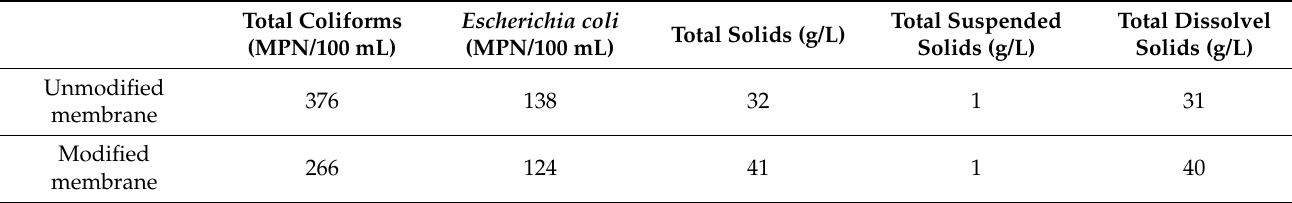
Table A1. Total coliforms and Escherichia coli (MPN/100 mL) and total solids, total suspended solids, and total dissolved solids (g/L) present in the surface water samples used in the filtration experiments using the unmodified and modified